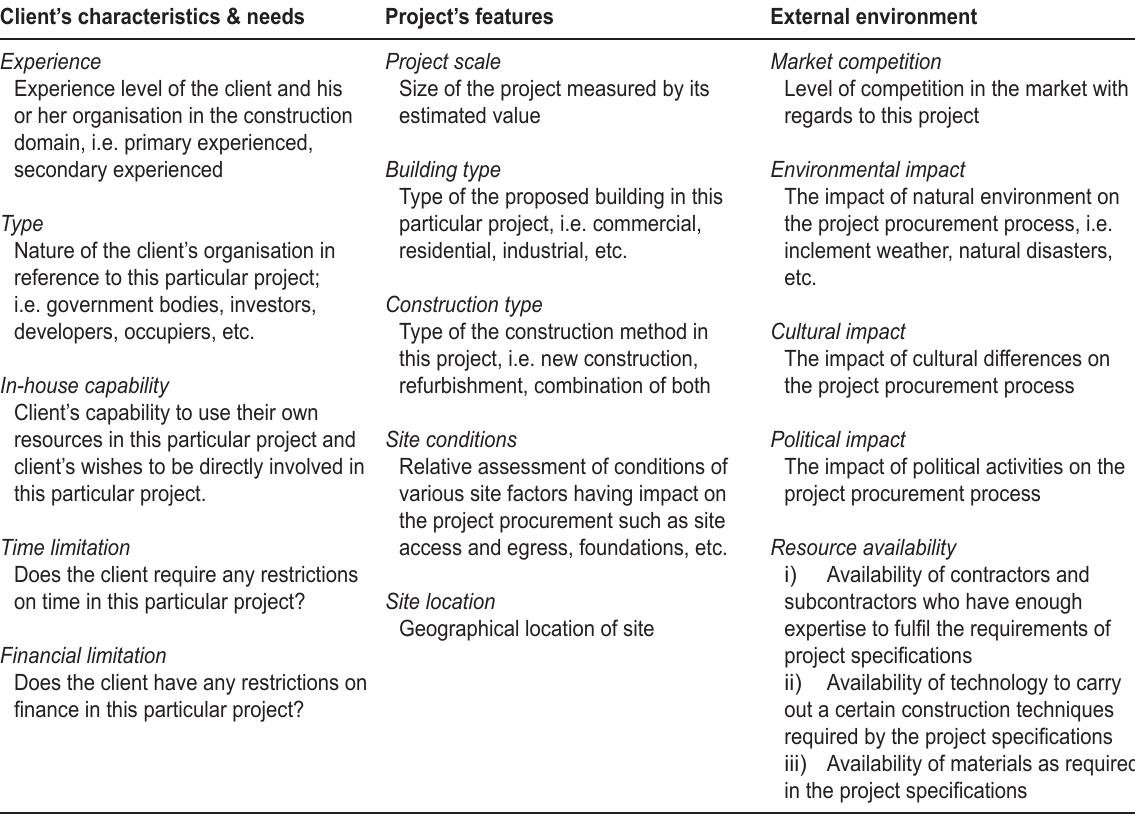
Table 1: Factors influencing the formulation of